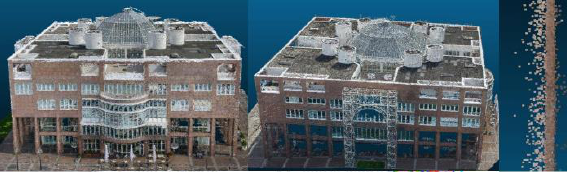
Figure 8. The City Hall Dortmund image point clouds